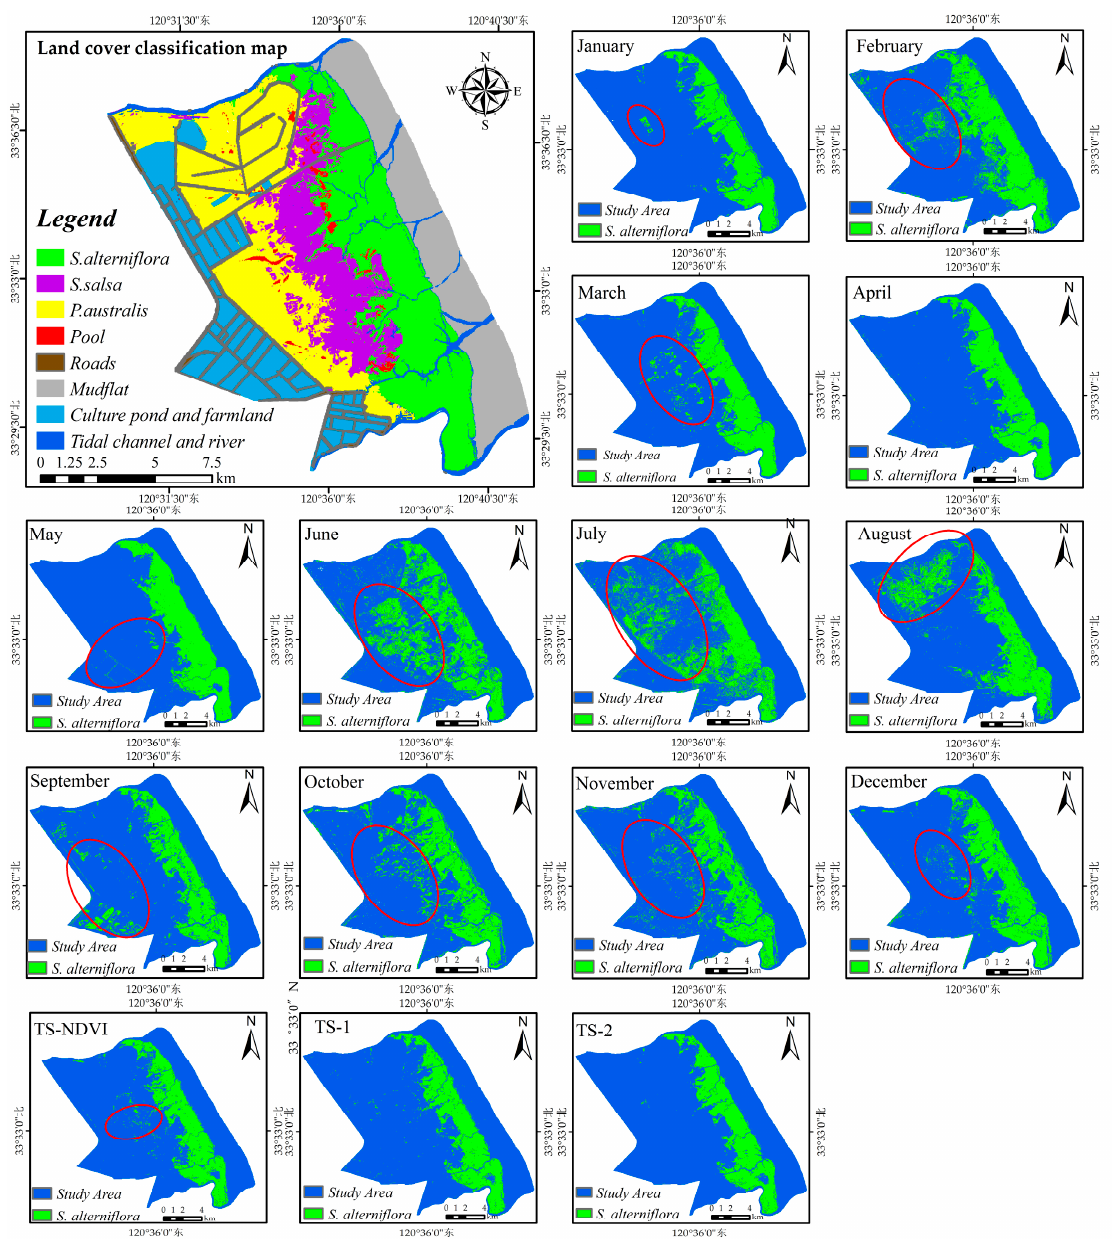
Figure 7. Classification map of S. alterniflora based on Maxent under the 15 schemes (January–December, TS-NDVI, TS-1, TS-2) from Patterns 1–3. The land cover classification map is based on the GE image from 2014. The red circles show the misclassification errors.